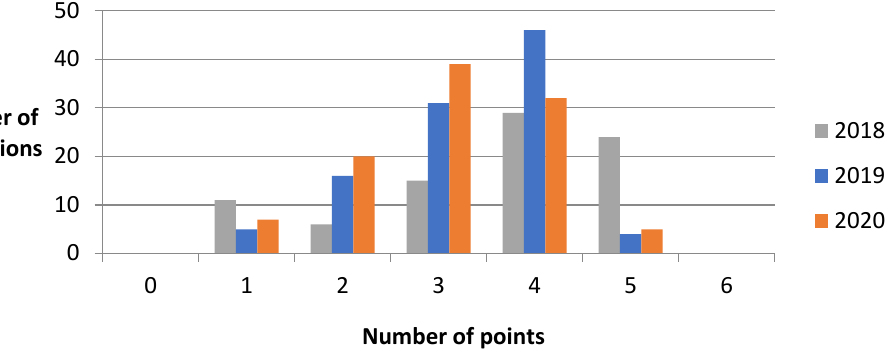
Figure 1. The total score of the formation of an integrated approach to the organisation of the regional system in the region.